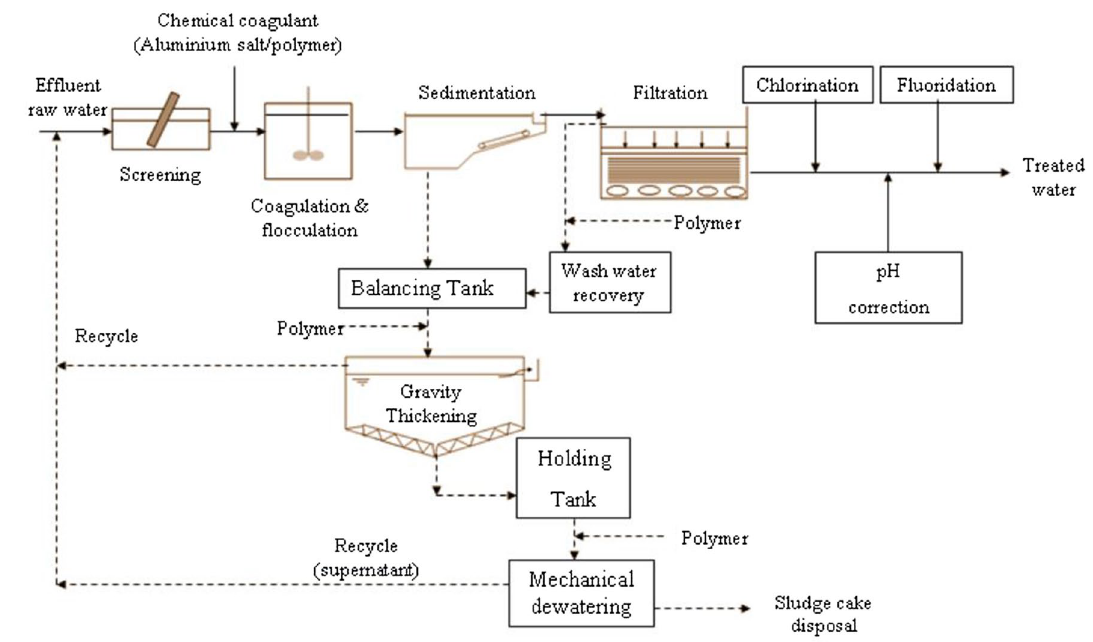
Fig. 1 Schematic representation flowchart of watercourses treatment plant and sludge stream in water works plant ( adapted from: EPA, 2002; Gregory and Dillon, 2002; Mazari et al. 2018; Zhao et al. 2021)